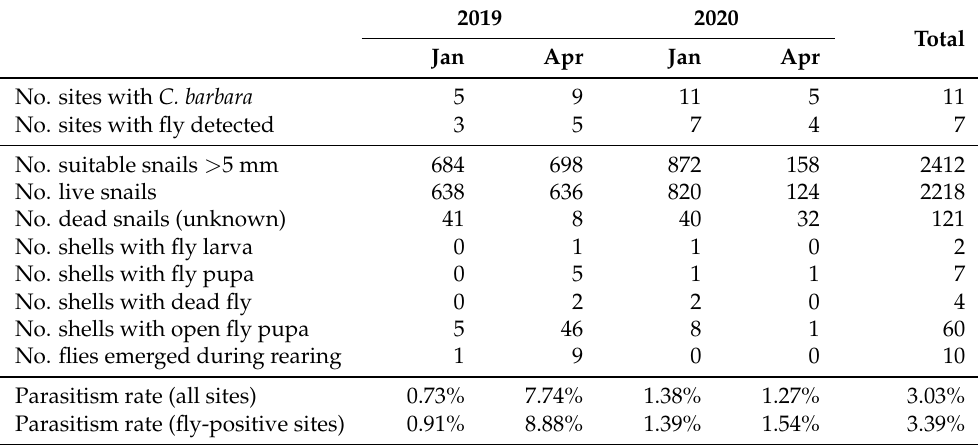
Table 2. Parasitism by S. villeneuveana of C. barbara on Yorke Peninsula, South Australia, in January and April of 2019 and